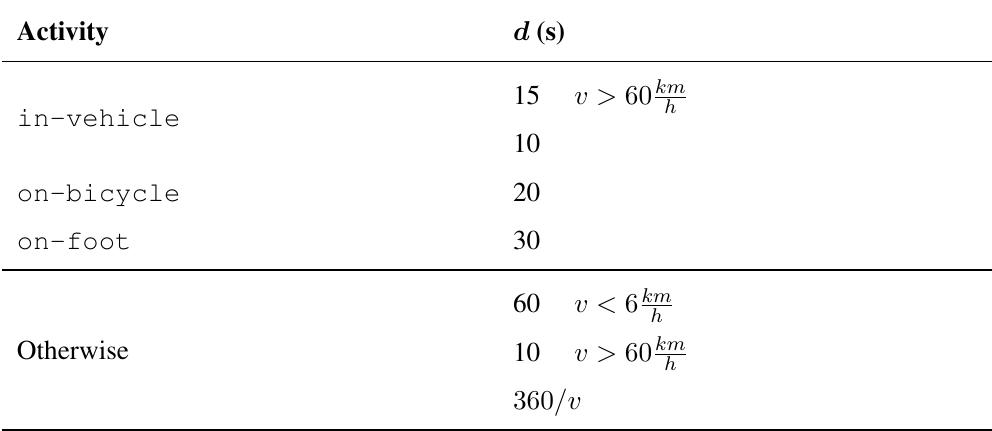
Table 3. Dependence of GPS pause time on user activity and